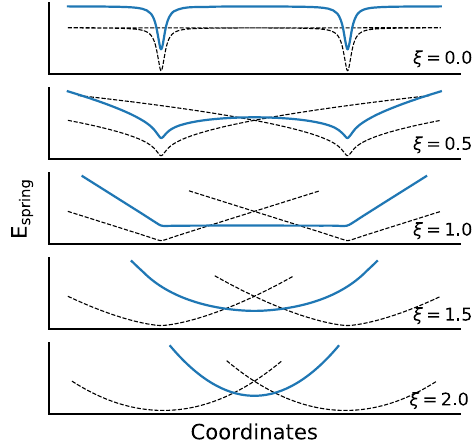
FIG. 9. The sum energy of two springs goes through a transition at ξ ¼ 1 . The energy minimum of each spring is preserved for ξ < 1 , while these minima are overwritten for ξ > 1 . In essence, the information on minima of ξ < 1 springs is stored with each individual spring. (Black dotted lines correspond to the individual potentials of two nonlinear springs with given ξ , bold blue lines show the sum of the two potentials, shifted up for